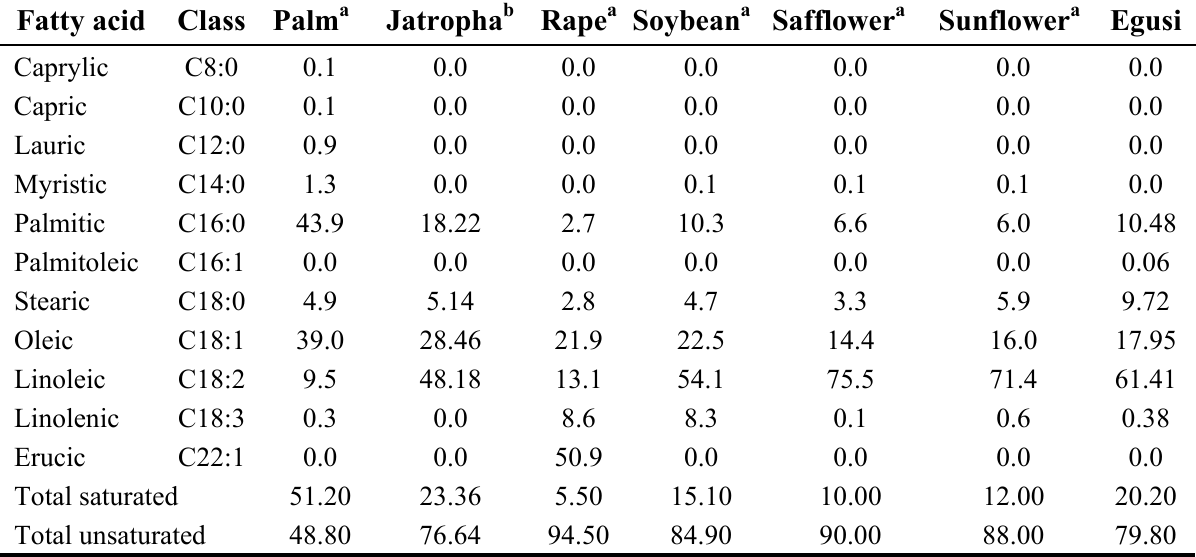
Table 2. Fatty acid compositions (wt%) of vegetable oils and egusi melon oil methyl